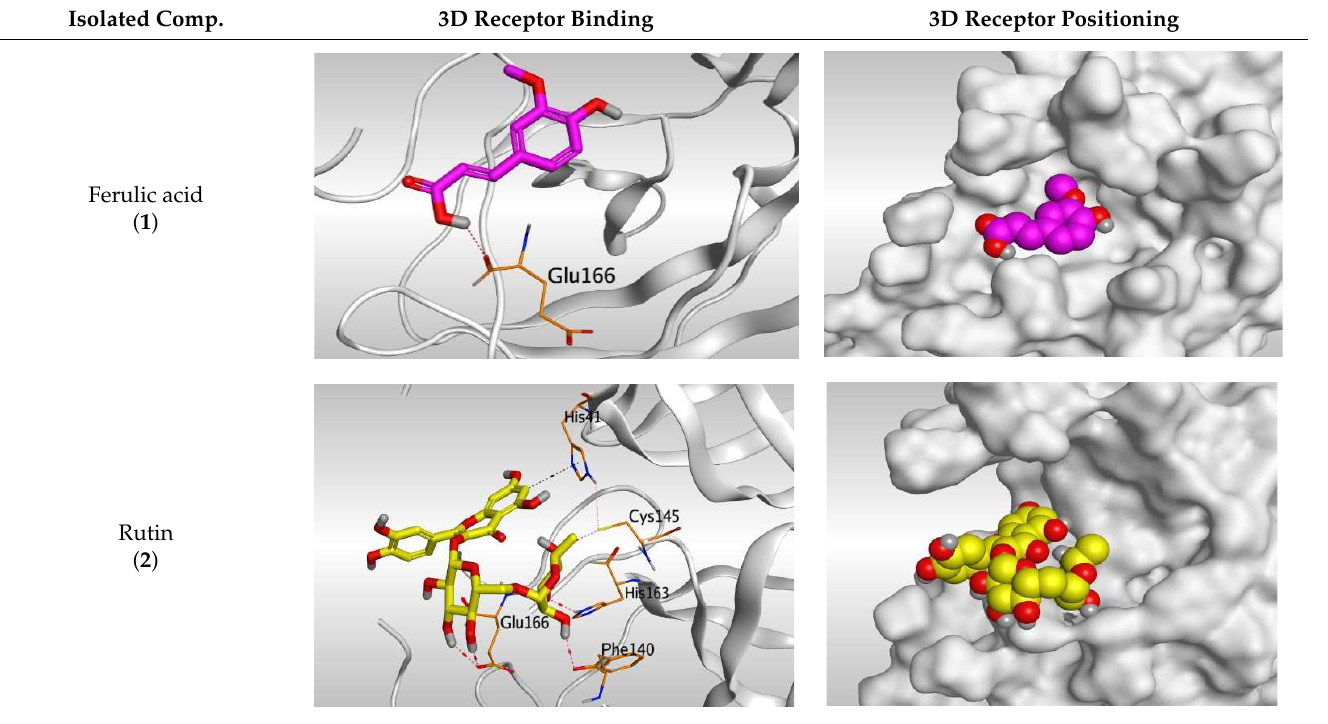
Table 3. 3D pictures of the receptor interactions and positioning between the examined isolated four compounds from P. dioica (L.) Merr extract ( 1 – 4 ) and the docked N3 inhibitor ( 5 ) inside the binding site of SARS-CoV-2 Mpro. The red dash represents H-bonds and the black one represents H-pi interactions. Isolated Comp.